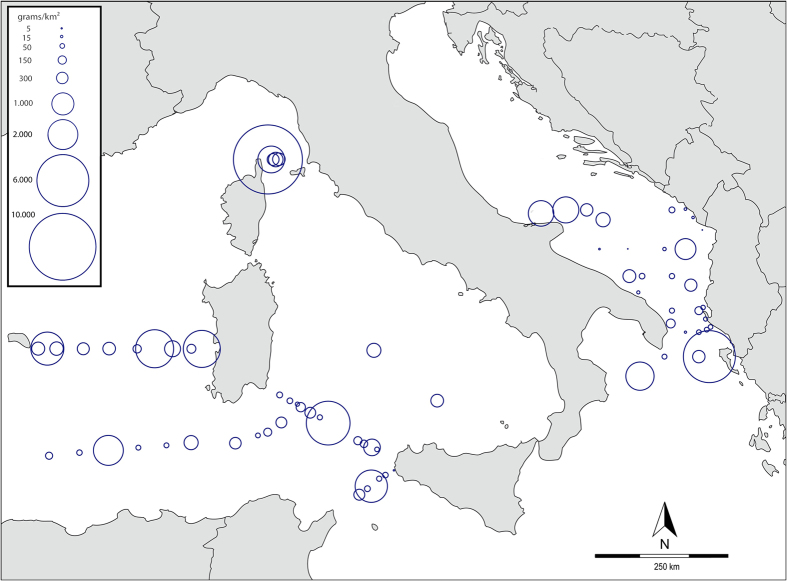
Map of the central-western Mediterranean Sea showing the location of all sampling stations and the distribution of un-corrected plastic densities expressed as grams of plastic per km2.Size of the circles is proportional to measured concentration values on a logarithmic scale. Particles <700 μm and synthetic fibers were not included in density calculations. Data were plotted using GPS Visualizer (http://www.gpsvisualizer.com/) and post-edited in Adobe Illustrator CS5. Background map freely retrieved from DEMIS OpenGIS Web Map Server under open copyright licence (http://www.demis.nl/home/pages/wms/docs/OpenGISWMS.htm).